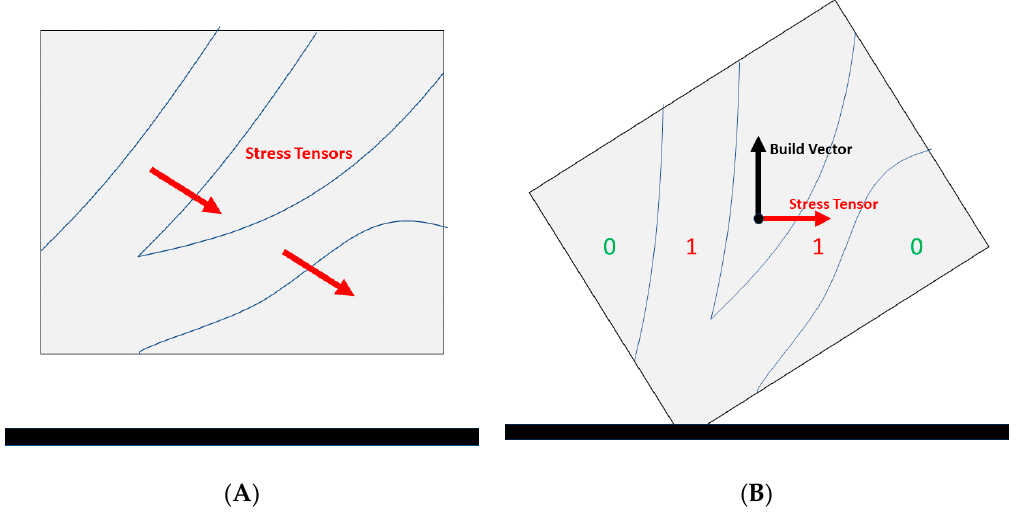
Figure 5. ( A ) AM part’s stress tensors. ( B ) Alignment of build orientation and stress tensors.